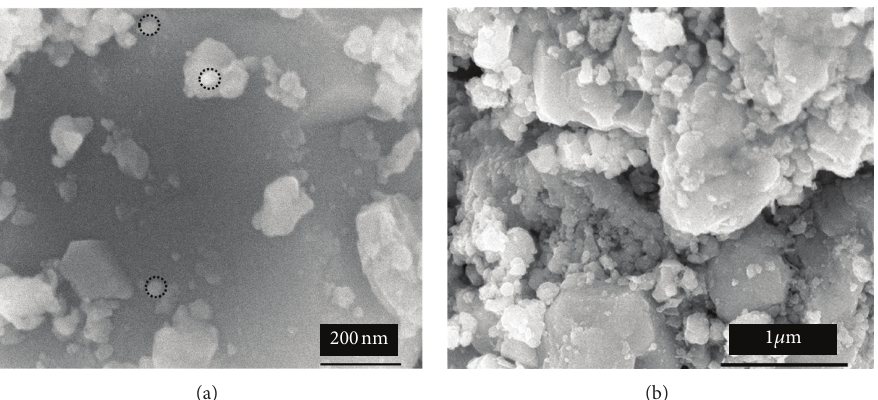
Figure 3: Scanning electron micrograph of (a) CZTS nanocrystals on copper substrate (nanoparticles of size ∼ 50 nm are shown within circle); (b) CZTS thin film, grown using nanocrystals.